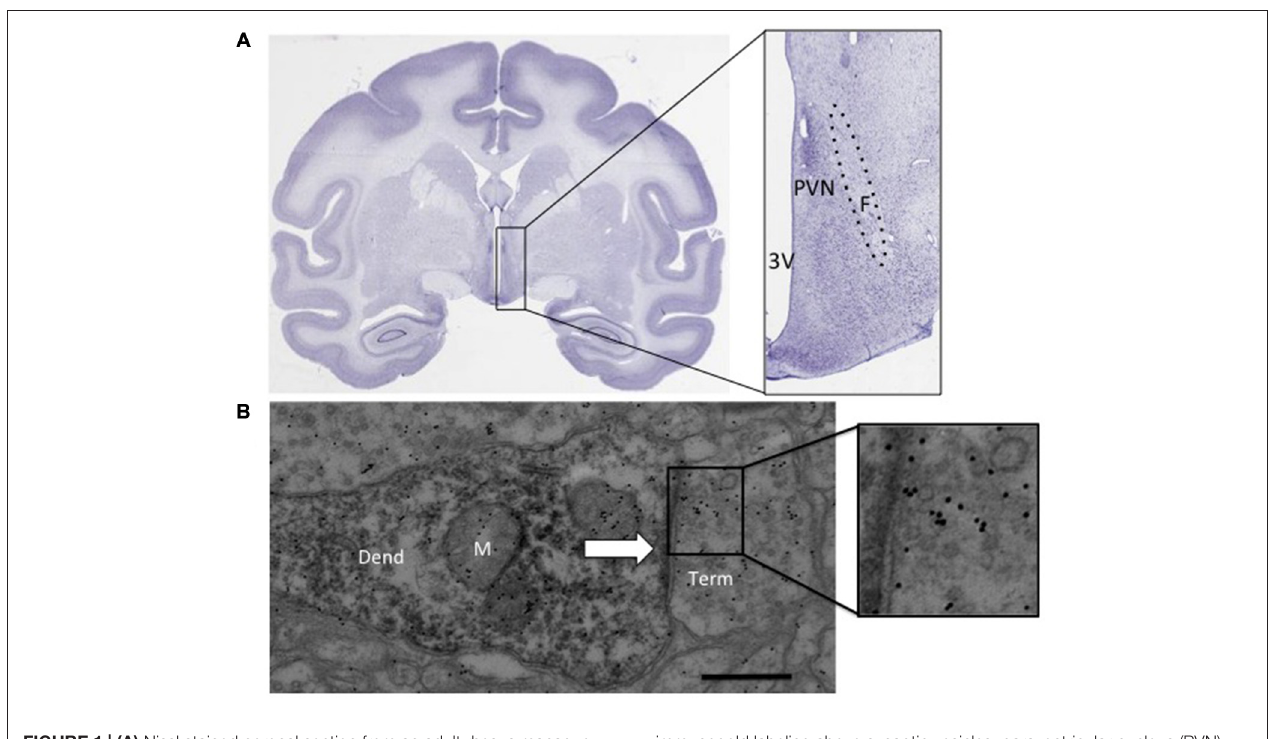
FIGURE 1 | (A) Nissl stained coronal section from an adult rhesus macaque brain (BrainMaps, 2014). The inset shows the approximate region dissected. (B) Immunoreactive dendrite with synaptic contact (arrow), inset shows